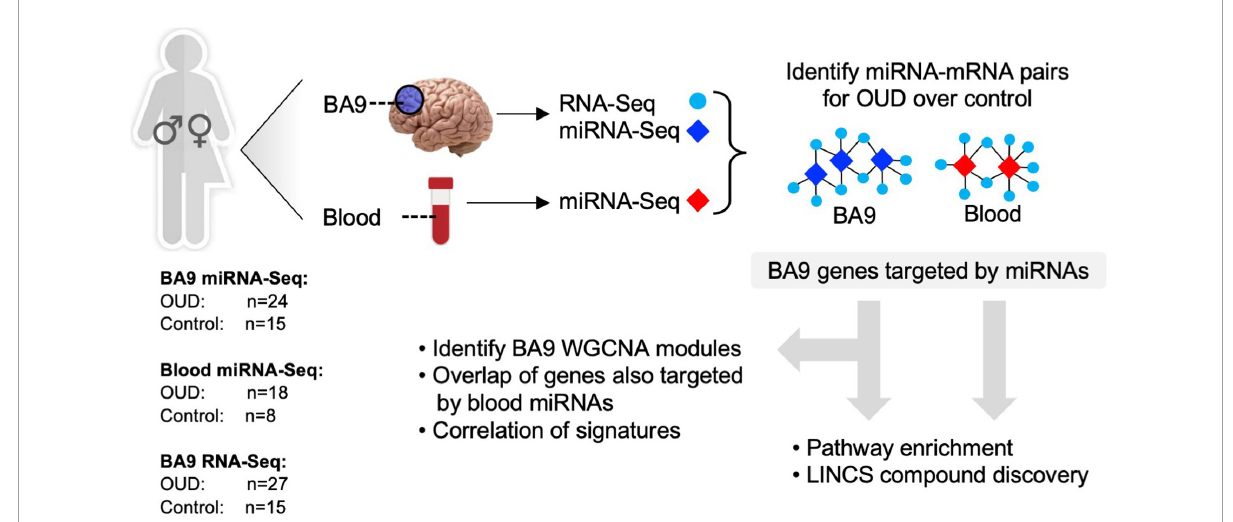
FIGURE1 Analytical approach overview. RNA-sequencing was carried out in brain tissue collected postmortem from individuals with opioid use disorder (OUD) and controls. smallRNA-seq was carried out in both brain and blood tissue from a subset of the same individuals. Dysregulated miRNA–RNA networks were inferred, and miRNA target genes were further investigated using pathway enrichment, repurposable drug identification, and correlation-based network